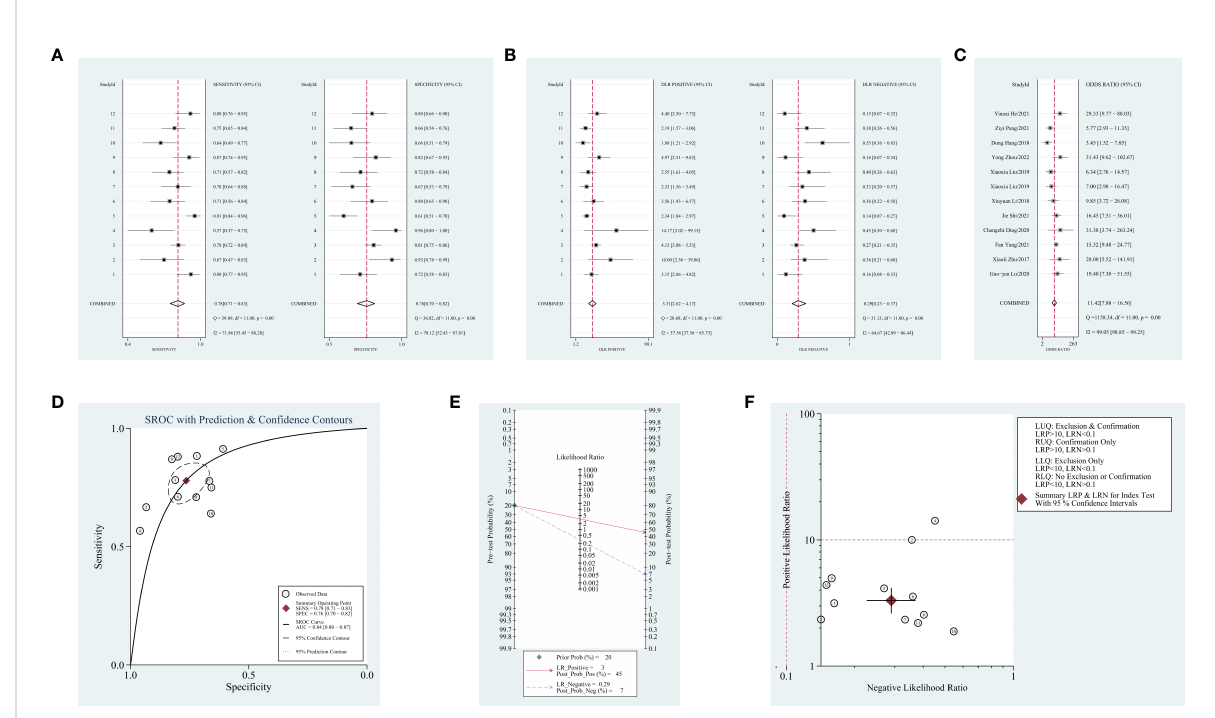
FIGURE 2 Forest plots of diagnostic accuracy index and summary receiver operating characteristic (SROC) curve and Fagan ’ s nomogram for likelihood ratios, a likelihood ratio scattergram, publication bias. (A) Forest plots of sensitivity and speci fi city for circular RNAs (circRNAs) in diagnosis. (B) Forest plots of the positive likelihood ratio and negative likelihood ratio in diagnosis. (C) Forest plots of the diagnostic odds ratio in diagnosis. (D) SROC curve for circRNAs in diagnosing non-small cell lung cancer (NSCLC). (E) Fagan ’ s nomogram for likelihood ratios. (F) A likelihood ratio scattergram.